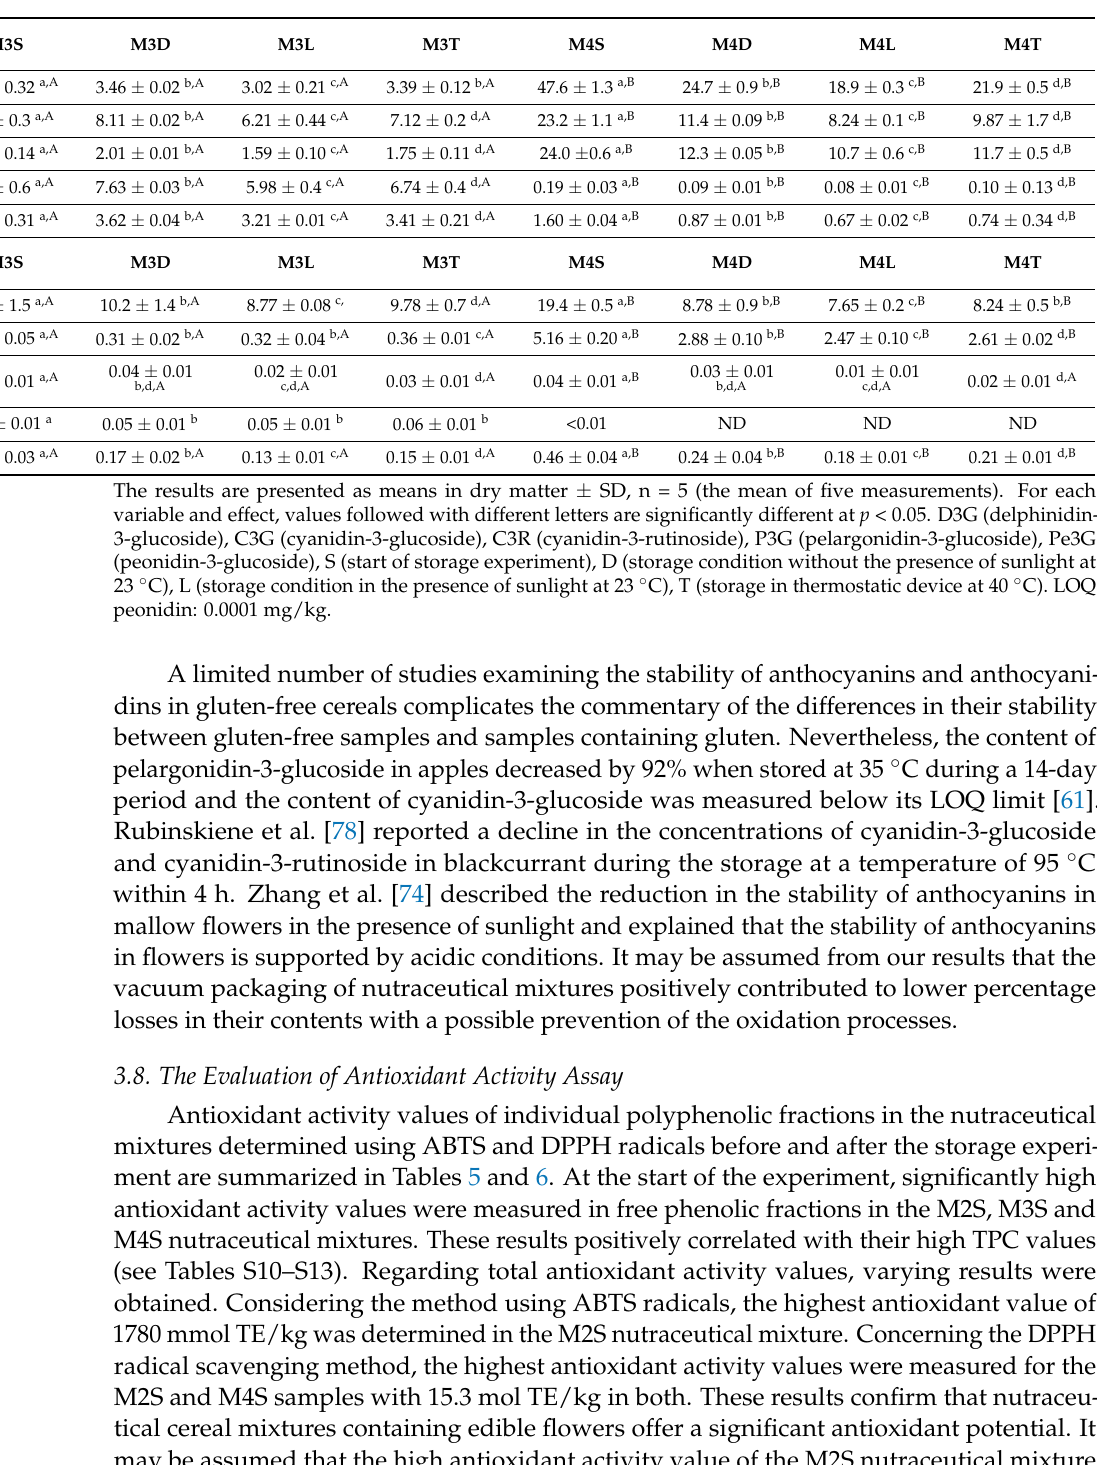
Table 4. Individual anthocyanin and anthocyanidin contents of the M3 and M4 nutraceutical mixtures under the defined storage